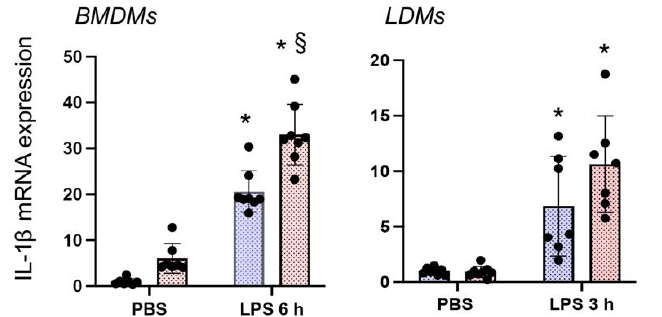
Figure 4. Nrf2 deficiency augments LPS-stimulated IL-1 β expression in both BMDM Φ s amd LDM Φ s. IL-1 β mRNA expression levels in BMDM Φ s and LDM Φ s isolated from male and female mice and treated with LPS for 6 h (BMDM Φ s) and 3 h (LDM Φ s), as in Figures 2 and 5, was analyzed by qRT-PCR. * versus PBS; § versus WT counterparts. LPS-stimulated IL-1 β mRNA levels in BMDM Φ s of male and female mice are shown in Figure S3.